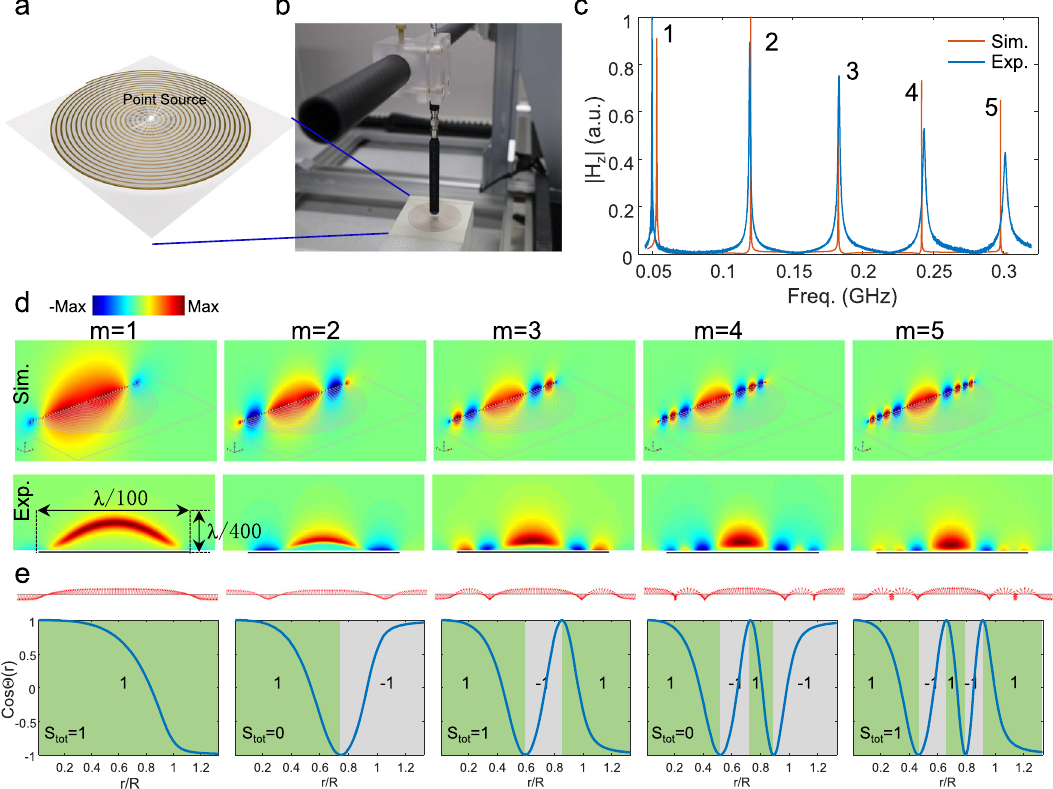
Fig. 3 Magnetic fi eld nature and topological features of LSP skyrmions in an ultrathin space-coiling meta-structure. a Schematic of the fabricated space-coiling meta-structure. b Experimental setup for near- fi eld scanning of all vectorial magnetic fi eld components of the skyrmion mode. c Measured (blue) and simulated (red) near-equidistant multi-resonant response spectra containing the fi rst fi ve modes. Measured quality factors for those modes are 165, 78, 62, 45, and 34, respectively. d Simulated (upper panel) and measured (lower panel) magnetic fi eld ( H z ) pro fi le at the central plane perpendicular to the sample ( xz -plane). e Unit vector con fi guration of magnetic fi eld distribution (upper panel) and cosine of the unit fi eld orientation angle distribution (lower panel) along the radial direction for each mode. Insets in the lower panel show the skyrmion number in each mode lobe, as well as the total skyrmion